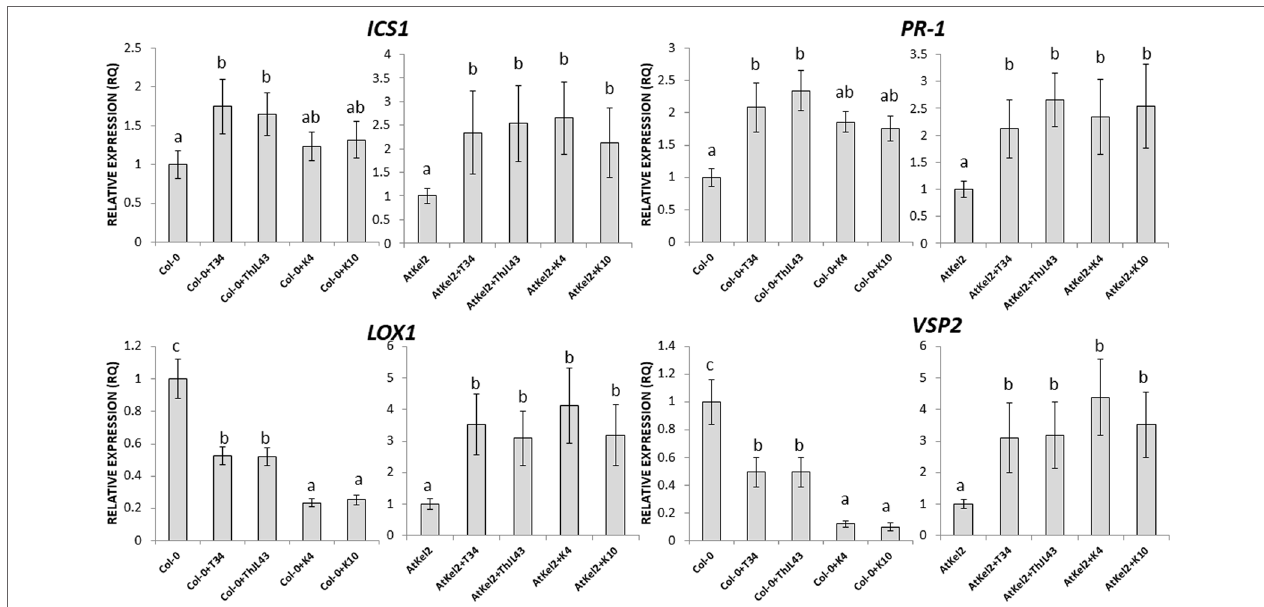
FIgURE 7 | Quantitative reverse transcription polymerase chain reaction (RT-qPCR) analysis of the expression of some defense genes in the leaves of A. thaliana wild type (Col-0) and transgenic line (AtKel2) plants, after inoculation with the control strain (+T34), the transformation control (+ThJL43), and the transformants with the silenced Thkel1 gene (+K4 and +K10) of T. harzianum . Genes of the isochorismate synthase 1 ( ICS1 ), pathogenesis-related protein 1 ( PR-1 ), lipoxygenase 1 ( LOX1 ), vegetative storage protein ( VSP2 ), and ethylene signaling protein ( EIN2 ). Values correspond to relative measurements against plants without inoculation (2 –ΔΔCt = 1). The Arabidopsis actin gene was used as an internal reference gene. Data are the mean of three biological replicates for each condition with the corresponding standard deviation, and for each biological replicate and condition, two leaves from three plants were used. One-way analysis of variance (ANOVA) was performed, followed by the Tukey’s test. Different letters represent significant differences ( P < 0.05) between plants with and without fungal